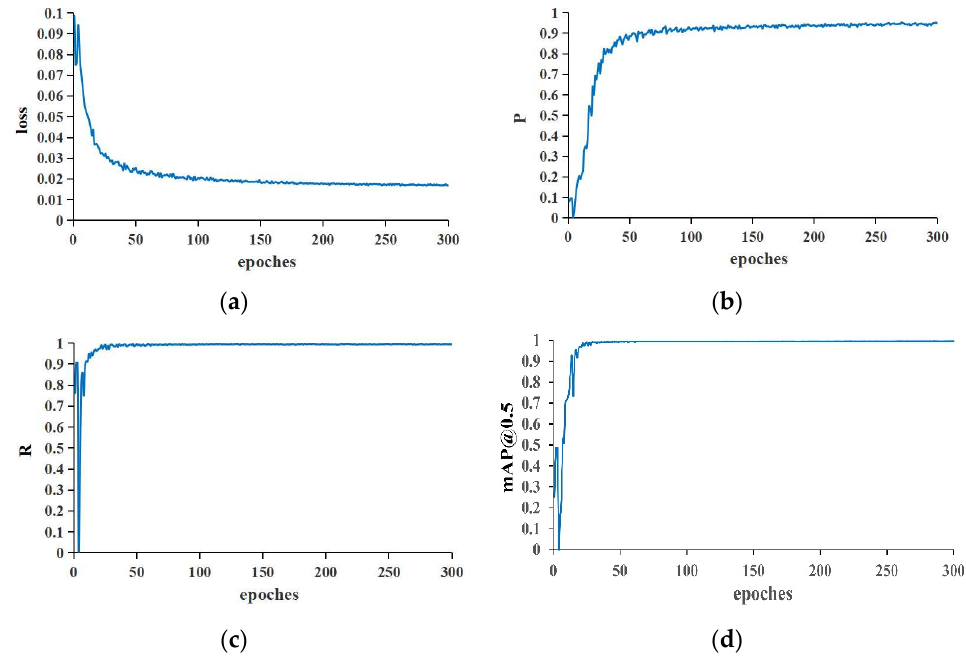
Figure 12. Model training results. ( a ) Value of loss varies with the number of iterations; ( b ) P vary with the number of iterations; ( c ) R vary with the number of iterations; ( d ) mAP@0.5 vary with the number of iterations.